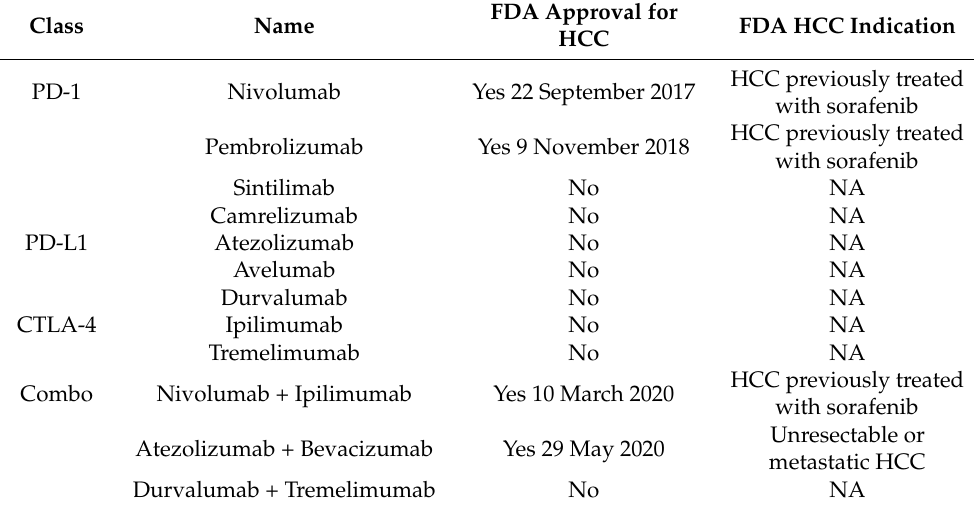
Table 1. Immune checkpoint